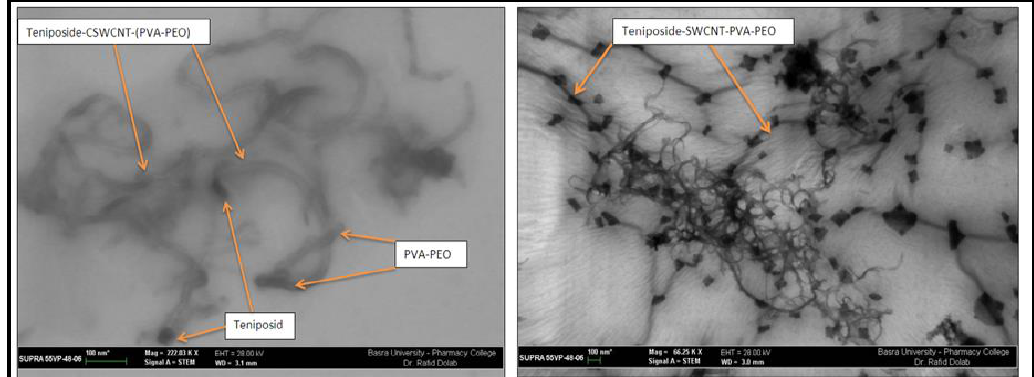
Figure (4) TEM images for teniposide-CSWCNT-(PVA-PEO) Solubility studies of teniposide in optimized